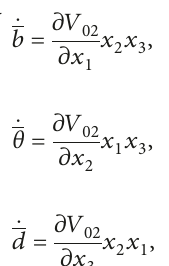
2 of system (29) with